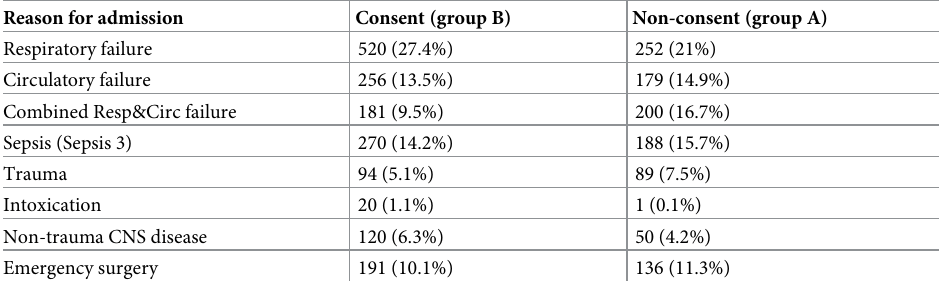
Table 3. Admission categories in the two groups (n and % within the